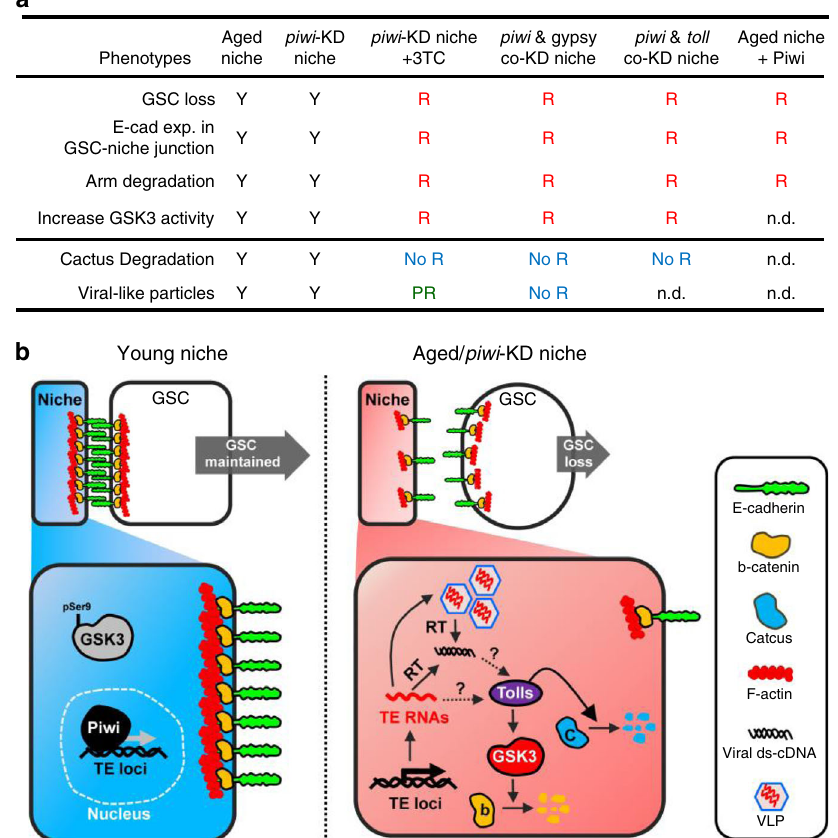
Fig. 6 Proposed model of how disrupted Piwi-mediated retrotransposon silencing impairs GSC maintenance. a Summary of phenotypes after aging, genetic manipulation and 3TC treatment of fl ies with piwi -KD niches. Y indicates presence of a given phenotype; R indicates rescue of the given phenotype; PR indicates partial rescue of the given phenotype; n.d. indicates not determined. b Model of how retrotransposon silencing by Piwi in the niche serves to maintain GSC attachment. Aging derepresses transposons/transposable elements (TEs) via reduction of Piwi. Decreased Piwi level derepresses TEs, which generate viral materials and activate Toll-GSK3 signaling to promote degradation of β -catenin. Loss of β -catenin impairs Cadherin-Catenin-Actin-mediated cell adhesion, leading to GSC loss. The mechanisms by which retrotransposons activate Toll receptor will require further examination. Dashed arrows with question marks indicate proposed